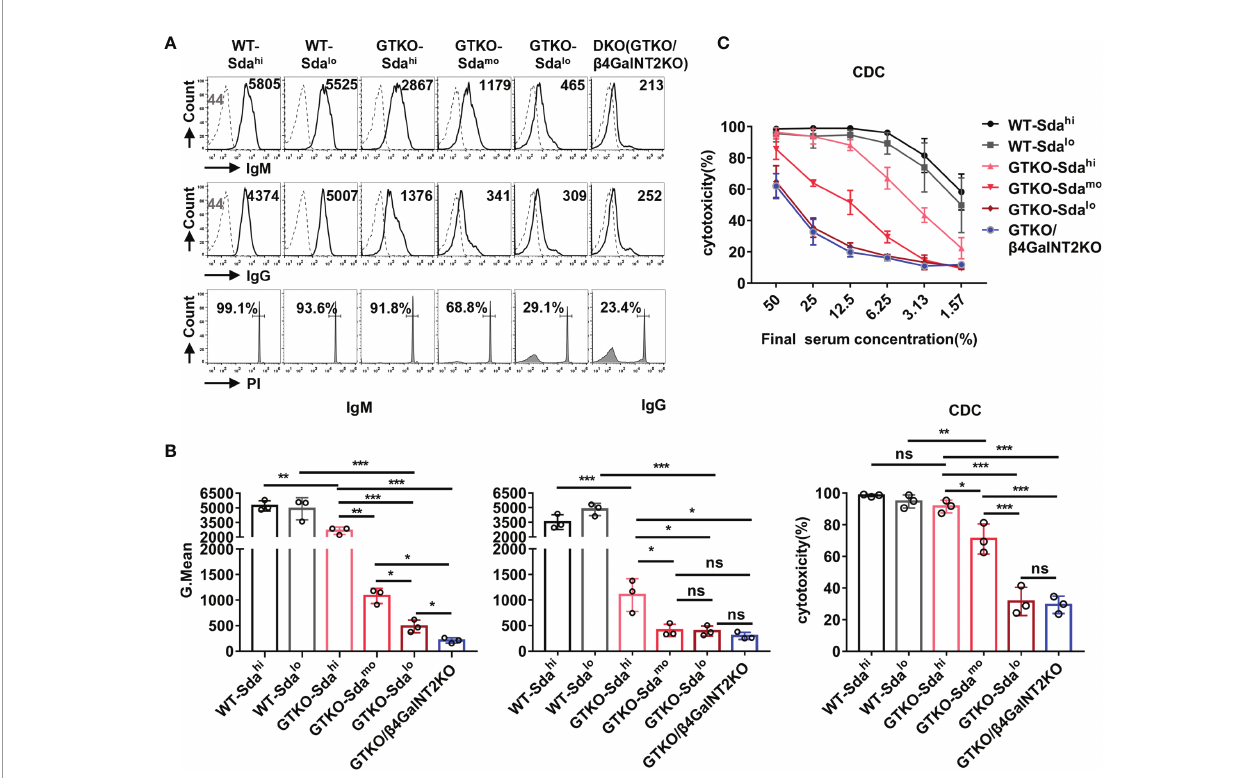
FIGURE 4 | The role of Sda expression in the binding of monkey serum antibody to GTKO pig PBMCs and in CDC against these cells. The IgM/IgG antibody binding and CDC were measured by fl ow cytometry after the co-culture of the pooled monkey sera with PMBCs from wildtype (Sda hi and Sda lo ), GTKO (Sda hi , Sda mo , and Sda lo ), or GTKO/ b 4GalNT2KO pigs. (A) Flow cytometric histograms showing representative binding of rhesus monkey IgM/IgG antibody (top/middle row, serum diluted 1:10, Gmean values were shown) to pig PBMCs and CDC (bottom row, serum diluted 1:6, percentages were shown) against the same PBMCs. (B) Statistical analysis of pooled rhesus monkey serum antibody binding (IgM and IgG) to pig PBMCs and CDC against the same PBMCs. (C) Comparison of mean serum CDC (at serum concentrations of 50% to 1.57%) of pooled rhesus monkey against WT, GTKO, or GTKO/ b 4GalNT2KO pig PBMCs. Each sample was measured three times. All data are presented as means ± SD (* P <0.05, ** P < 0.01, *** P < 0.001; ns, non-signi fi cant). The P value comes from three independent